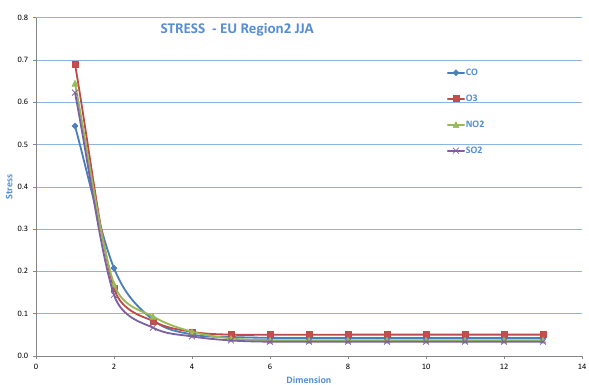
Fig. 5. Subspace dimension calculated by minimising the stress function in the MDS methodology. The corr( d i , d j ) matrix is used as similarity